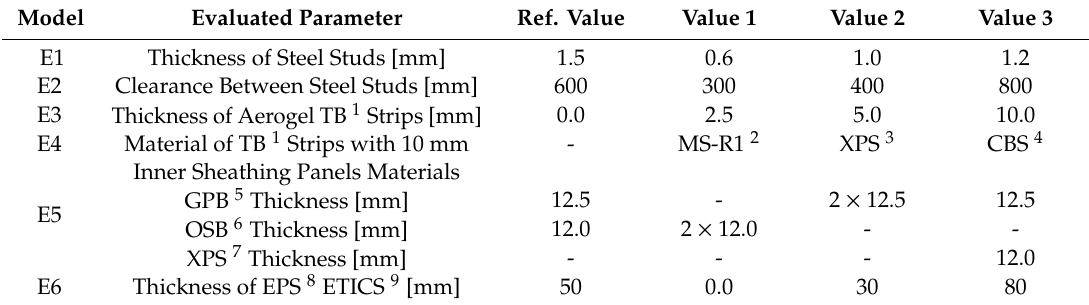
Table 5. Exterior facade LSF wall: models and parameters values to be evaluated. Model Evaluated Parameter Ref.